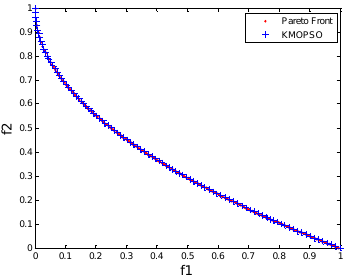
Fig. 11. Pareto fronts produced by KMOPSO for ZDT3.